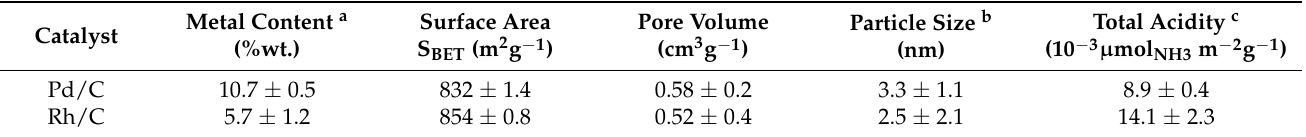
Table 1. Characterization of Pd/C and Rh/C